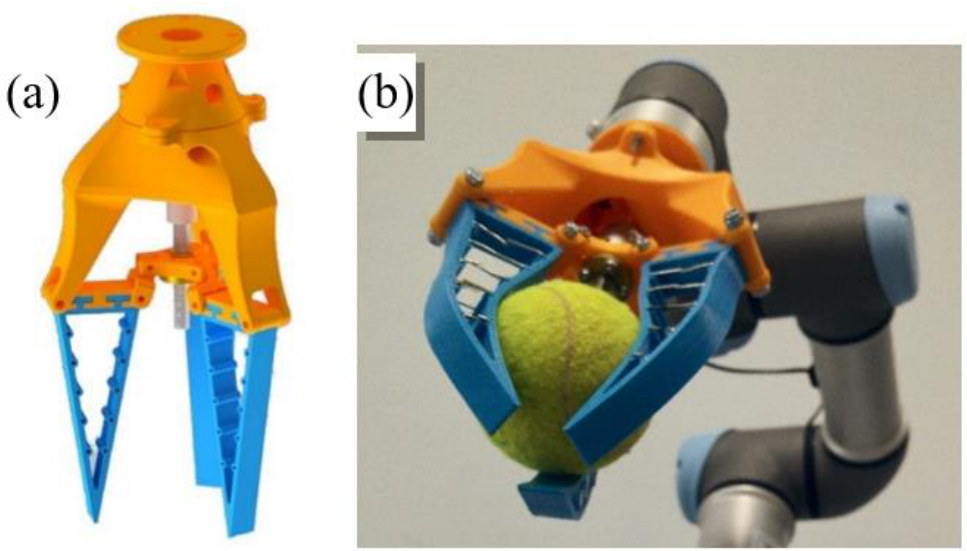
Figure 7. Fourth gripper: ( a ) CAD model of the gripper, ( b ) Gripper during the operation.